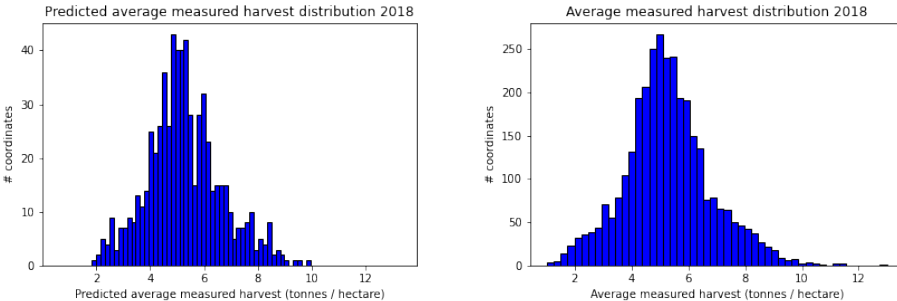
Figure 11. The predicted yield distribution for 2018 ( left ), obtained using an LGBM model with grid G-50 and input “All features”, closely matched the true yield distribution ( right ). The model accurately captured the shape, mean, and variance of the true distribution for this year.